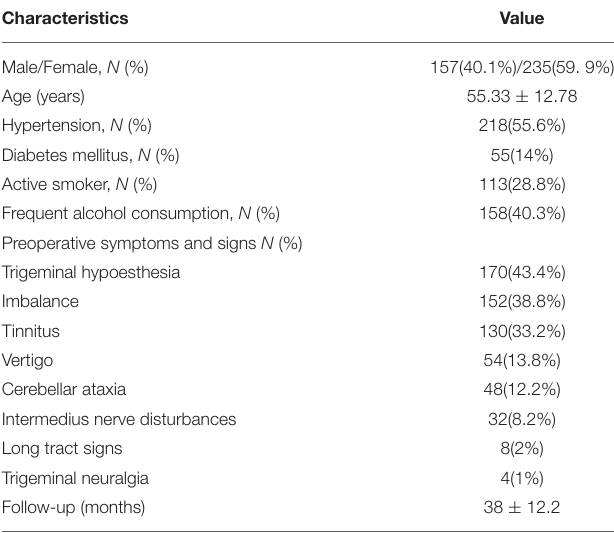
TABLE 1 | Population study